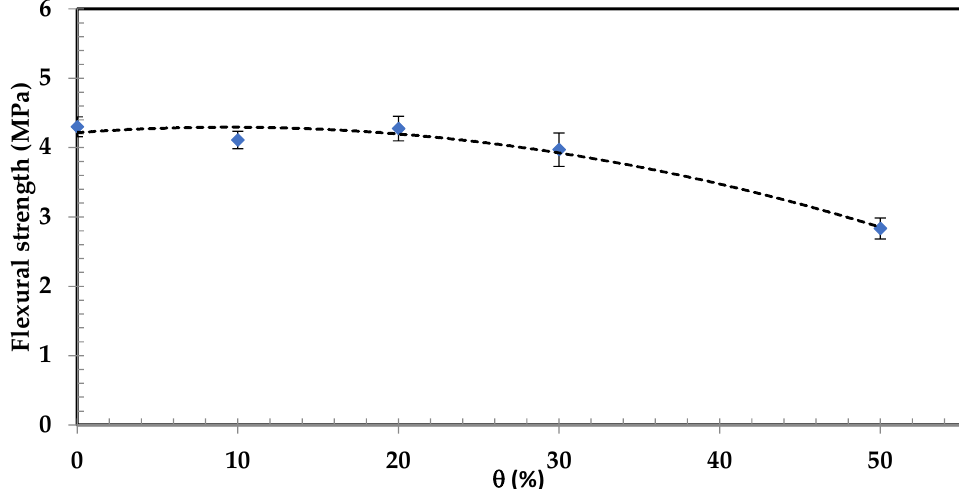
Figure 13. Flexural strength influence of concrete reinforced with different volume percentages of RWG.